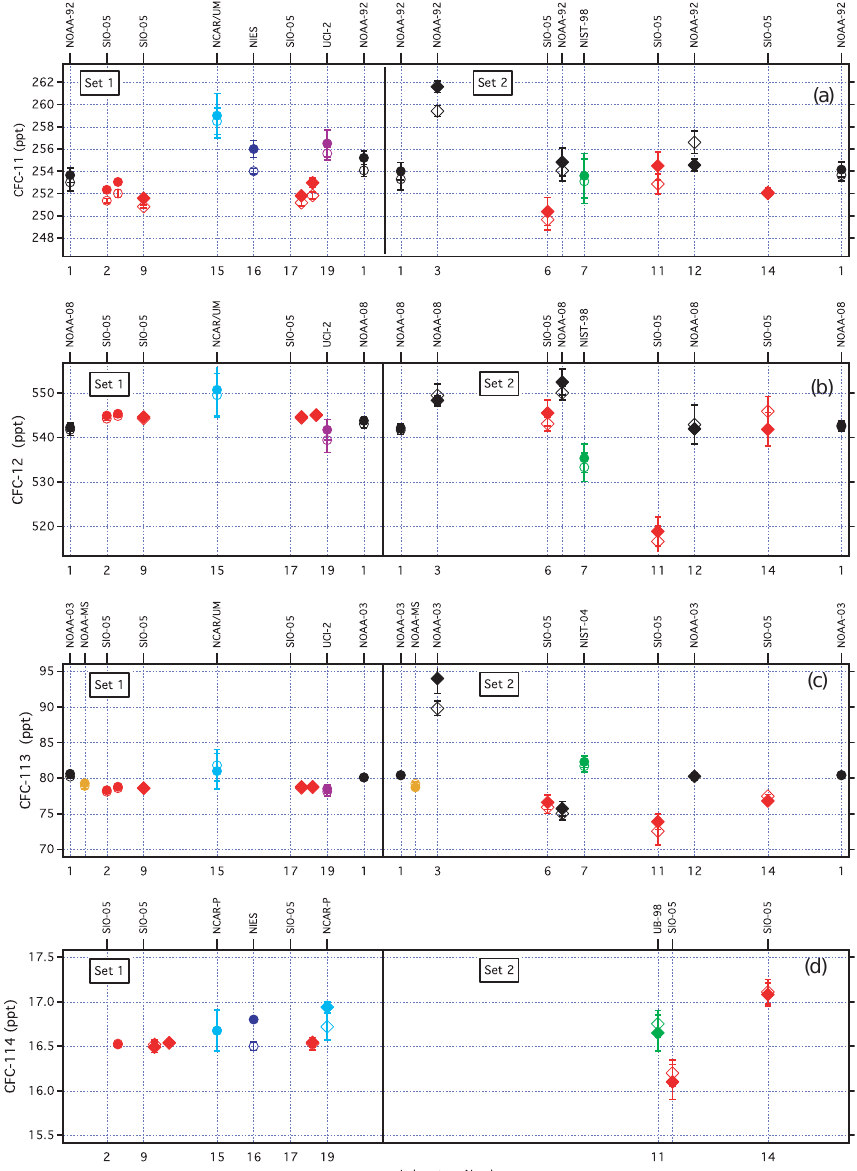
Fig. 1. Results from undiluted samples for (a) CFC-11, (b) CFC-12, (c) CFC-113, (d) CFC-114, (mole fraction, ppt = pmolmol − 1 , parts per trillion) color-coded by calibration scale with scale identifiers shown along the top axis: open (closed) symbols correspond to cylinders filled in winter (summer); circles denote laboratories that develop scales and serve as a scale origin, diamonds denote laboratories that adopt existing scales. Errors bars are one standard deviation as reported. Results that appear offset from the integer laboratory numbers on the x axis indicate additional results submitted by the corresponding laboratory (different instruments, different calibration scales, etc.). For example, for CFC-11 laboratory 2 submitted data from two instruments on the same scale, while laboratory 6 submitted data on two different scales. Note that because some laboratories adopt scales from others, the scale identifier (top axis) and the laboratory (identified by number on the bottom axis) may differ (see Table 1). For example, in (c) , laboratory 19 (UCI-2) reports CFC-113 on the UCI-2 scale, but in (d) , reports CFC-114 on the NCAR-P